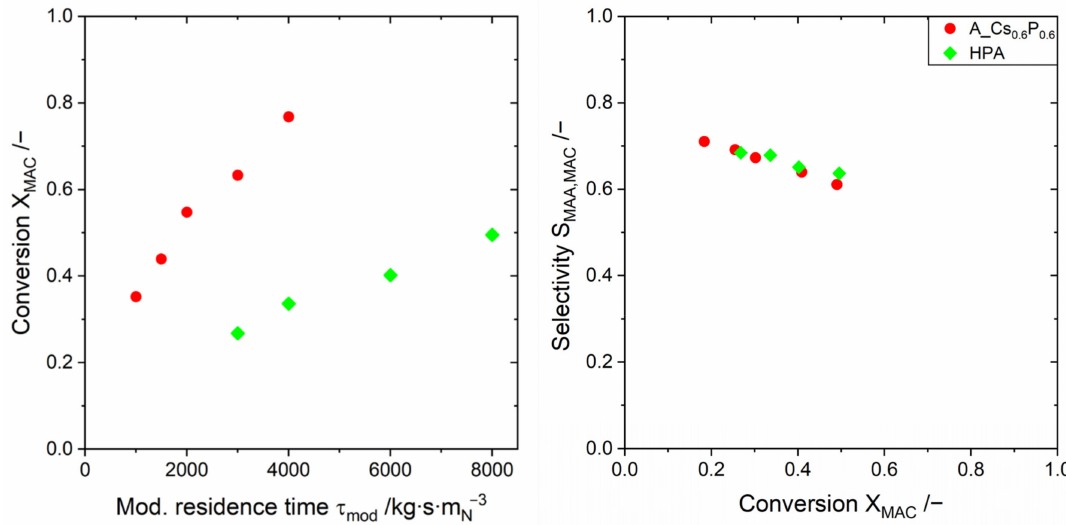
Figure 10. Comparison of the catalytic performance of A_Cs 0.6 P 0.6 with the directly synthesized HPA at 300 ◦ C and 21% v/v water. MAC conversion over modified residence time ( left ) and MAA selectivity over MAC conversion ( right